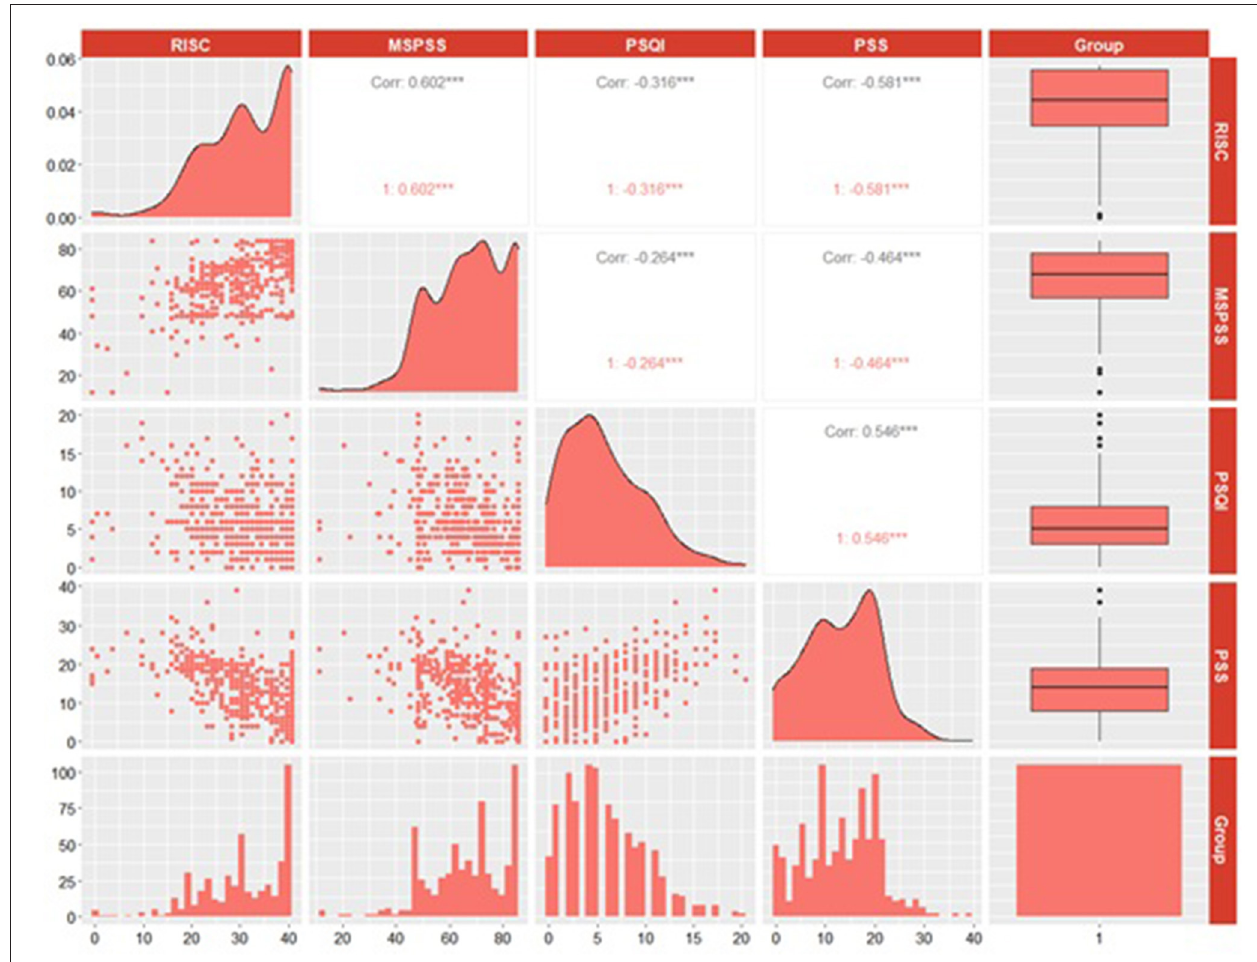
FIGURE 2 | Correlation analysis of PSS, MSPSS, PSQI, and CD-RISC-10.